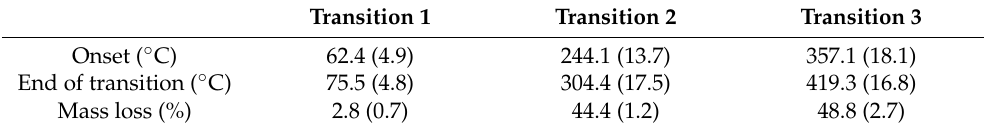
Table 3. Degradation transition temperatures and associated mass loss (SD between brackets).